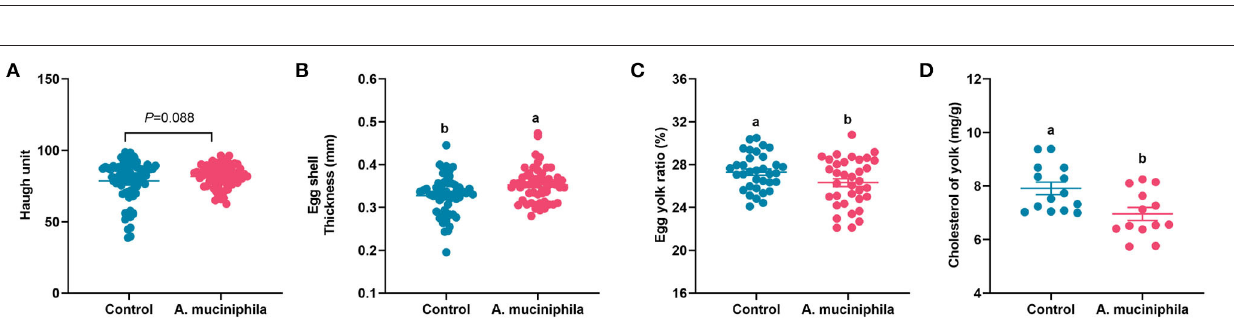
FIGURE 6 | Akkermansia muciniphila supplementation ameliorated lipid metabolism in aged laying hens ( n = 7). (A) Liver and abdominal fat weight. (B) Liver and abdominal fat index. (C) Serum total cholesterol (TC) and triglyceride (TG) levels. (D) Hepatic TC and TG levels. (E) Relative mRNA expression of lipid metabolism-related genes in the liver. The expression levels of genes in the control group were set as 1 and the relative fold increases were determined by comparison with the control group. (F) Diagram representing the anatomy of the liver and abdominal fat. Different letters indicate significant differences at p < 0.05. FAS , fatty acid synthase; SCD1 , stearoyl-CoA desaturase 1; LXR α , liver X receptor alpha; HMGCR , 3-hydroxy-3-methylglutaryl-CoA reductase; PPAR- γ , peroxisome proliferator-activated receptor gamma; L-FABP , liver fatty acid binding protein; PPAR- α , peroxisome proliferator-activated receptor alpha; ABCA1 , ATP-binding cassette transporter A1.